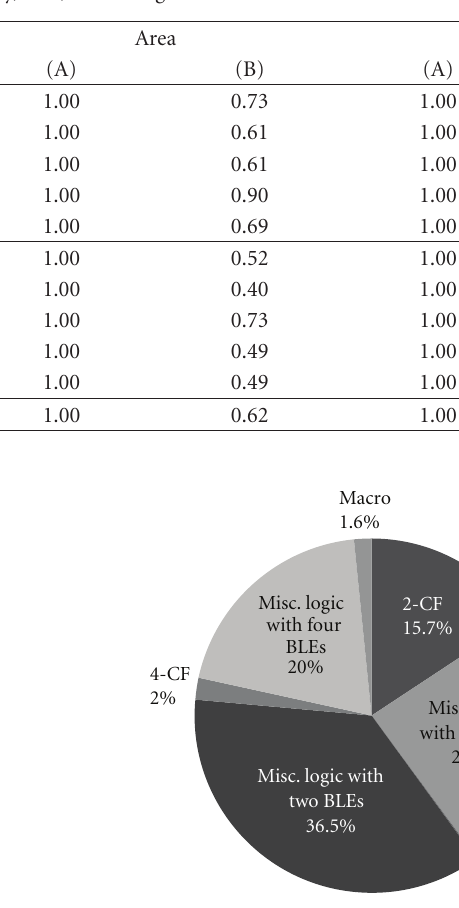
Table 5: Normalized delay, area, and configuration data.